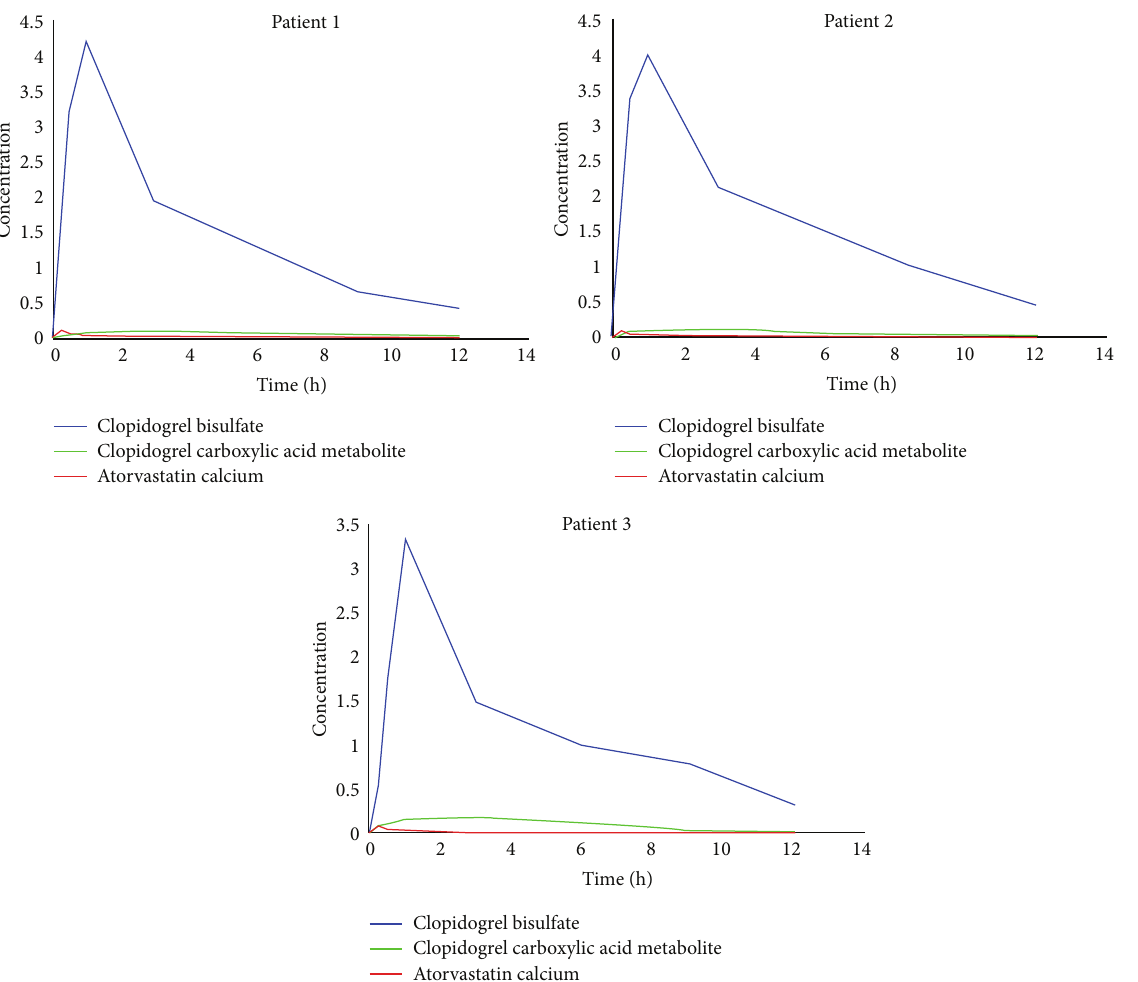
Figure 6: Plasma levels of clopidogrel, its carboxylic acid metabolite, and atorvastatin versus time following administration of 75 mg clopidogrel and 20 mg atorvastatin daily (patient 1), 75 mg clopidogrel and 40mg atorvastatin daily (patient 2), and 75 mg clopidogrel and 80 mg atorvastatin daily (patient